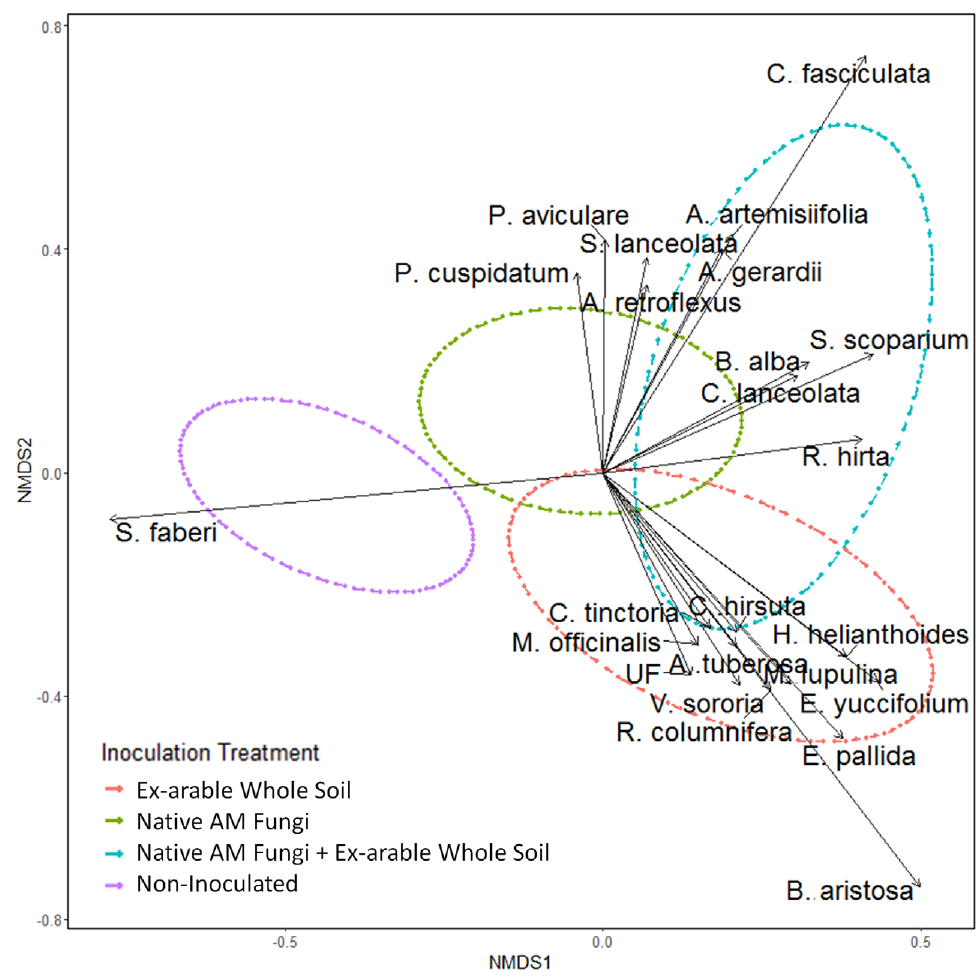
Figure 1. NMDS ordination of plant community composition among the four soil inoculation treatments (indicated by ellipse and color). The vectors are plant species contributing ( p < 0.10 from intrinsic species analysis; Table 1) to the differences in plant communities among inoculation treatments. Table 1. NMDS axes scores and p -values of the plant species contributing ( p < 0.10) to the separation in plant community composition among inoculation treatments.